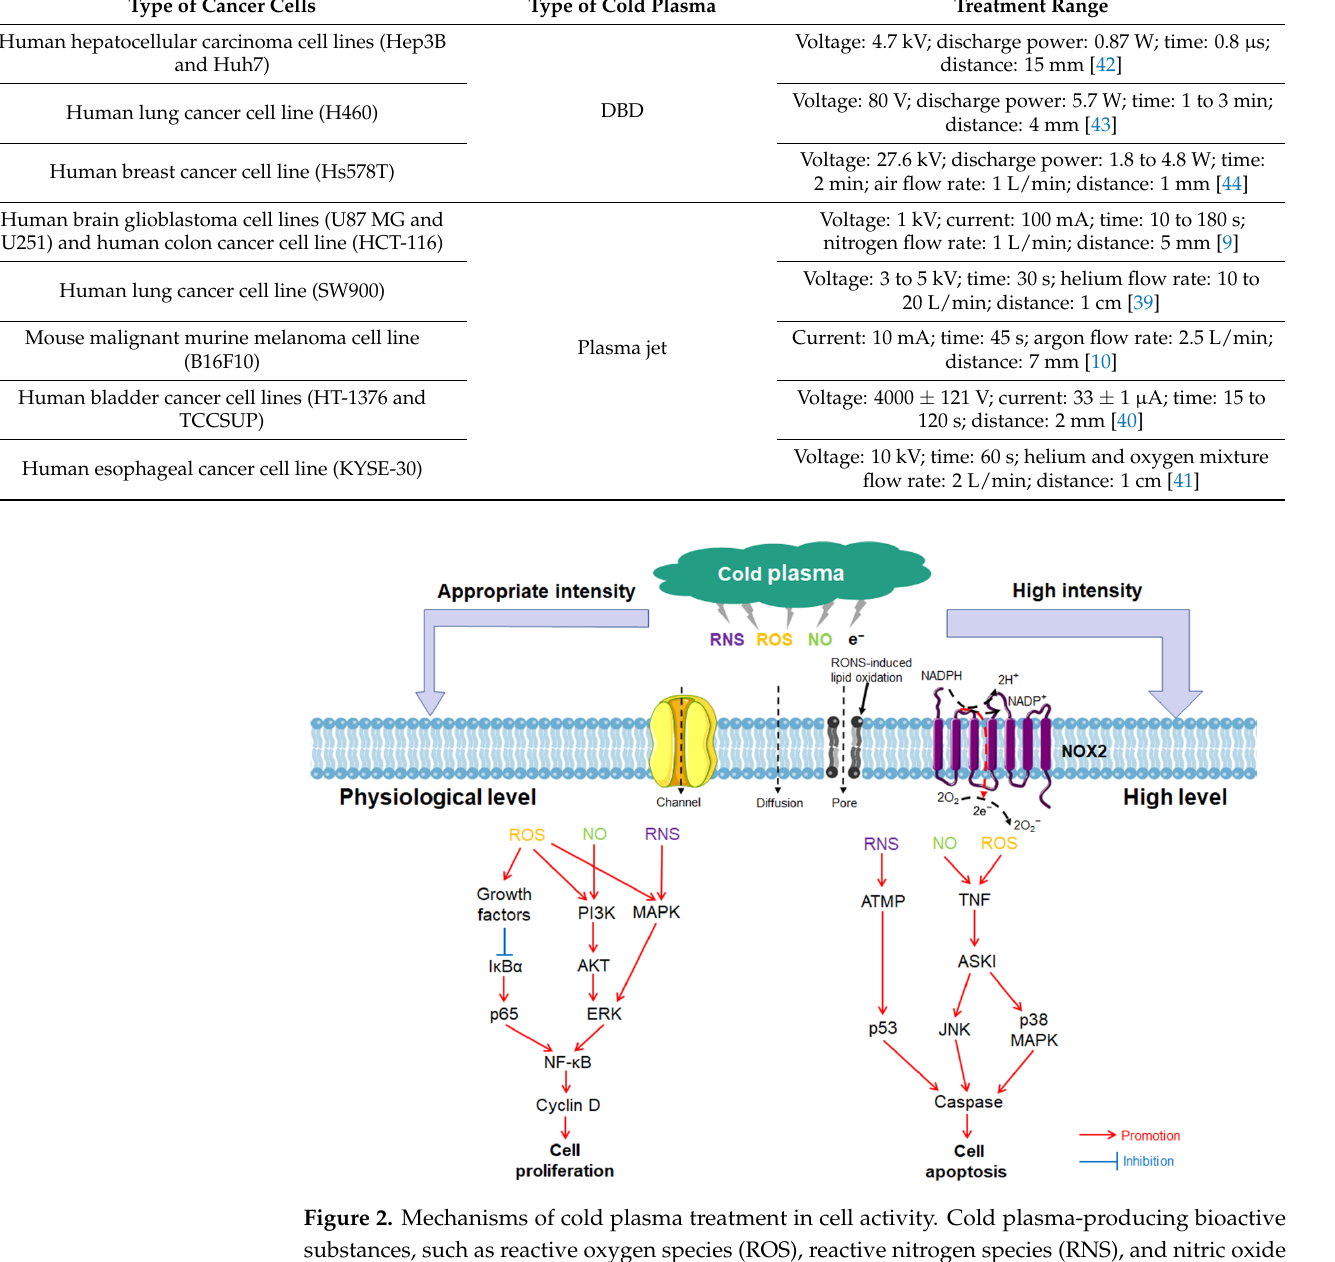
Table 2. Cold plasma treatment ranges for different cancer cells.